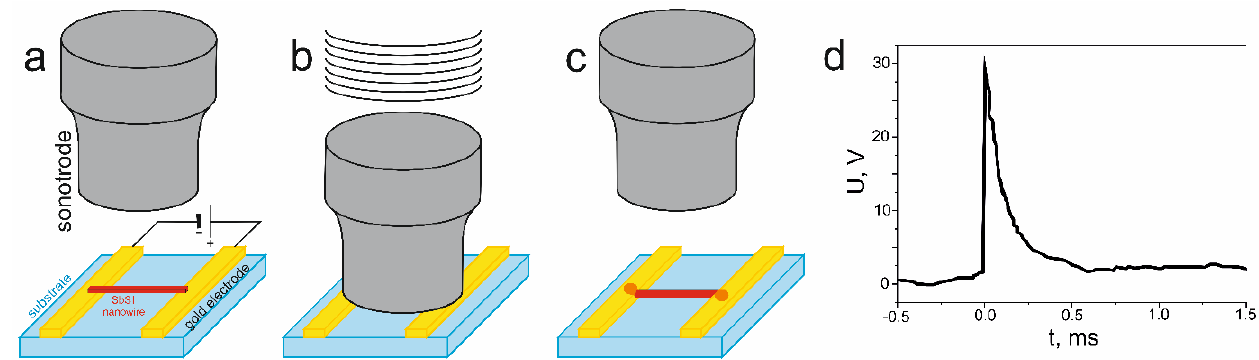
Figure 12. Scheme for the fabrication of a nanogenerator based on single SbSI nanowires: ( a ) alignment of the nanowires in an external electric field, ( b , c ) ultrasonic bonding of SbSI nanowires to the electrodes, and ( d ) the electrical response of the nanogenerator registered under a shock wave.